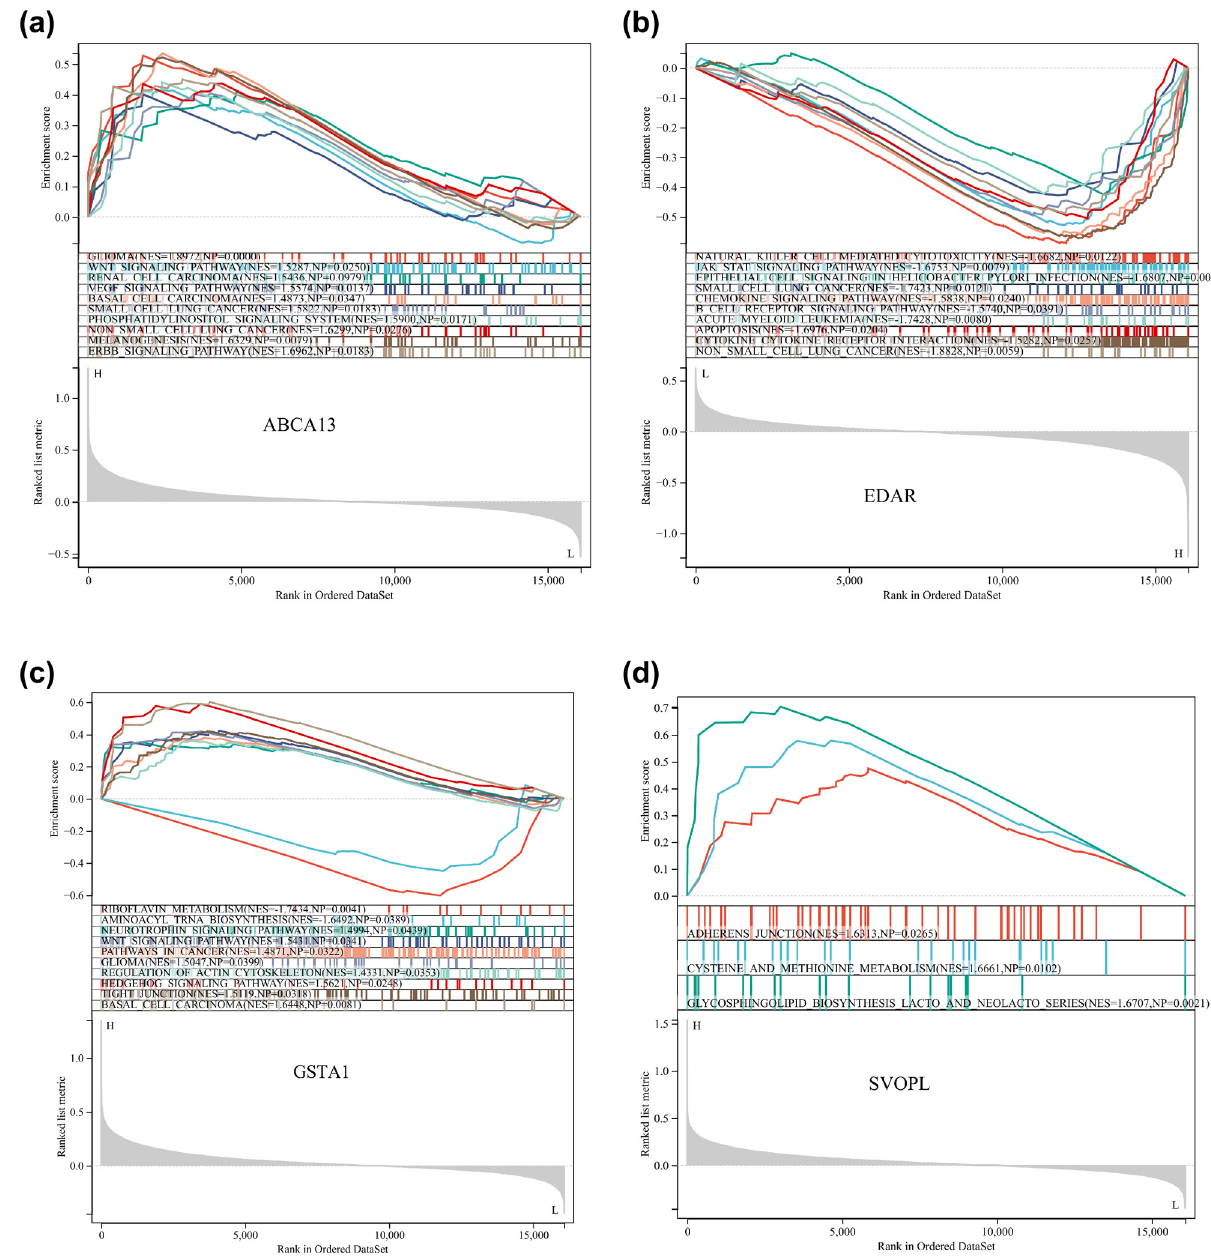
Figure 5: Single - gene GSEA of hub genes. GSEA of ( a ) ABCA13, ( b ) EDAR, ( c ) GSTA1, and ( d )